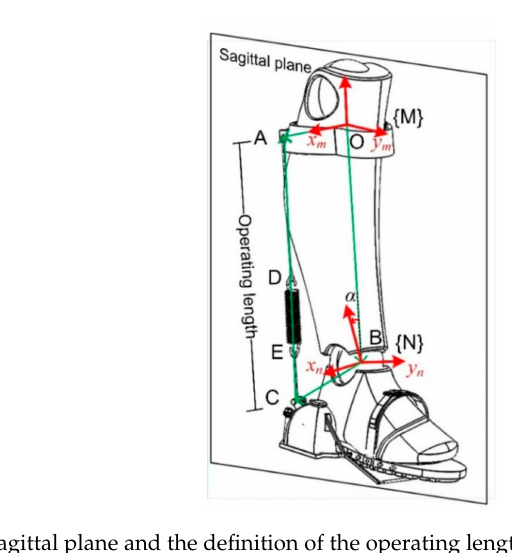
Figure 7. The sagittal plane and the definition of the operating length. x n and x m are all perpendicular to the sagittal plane.